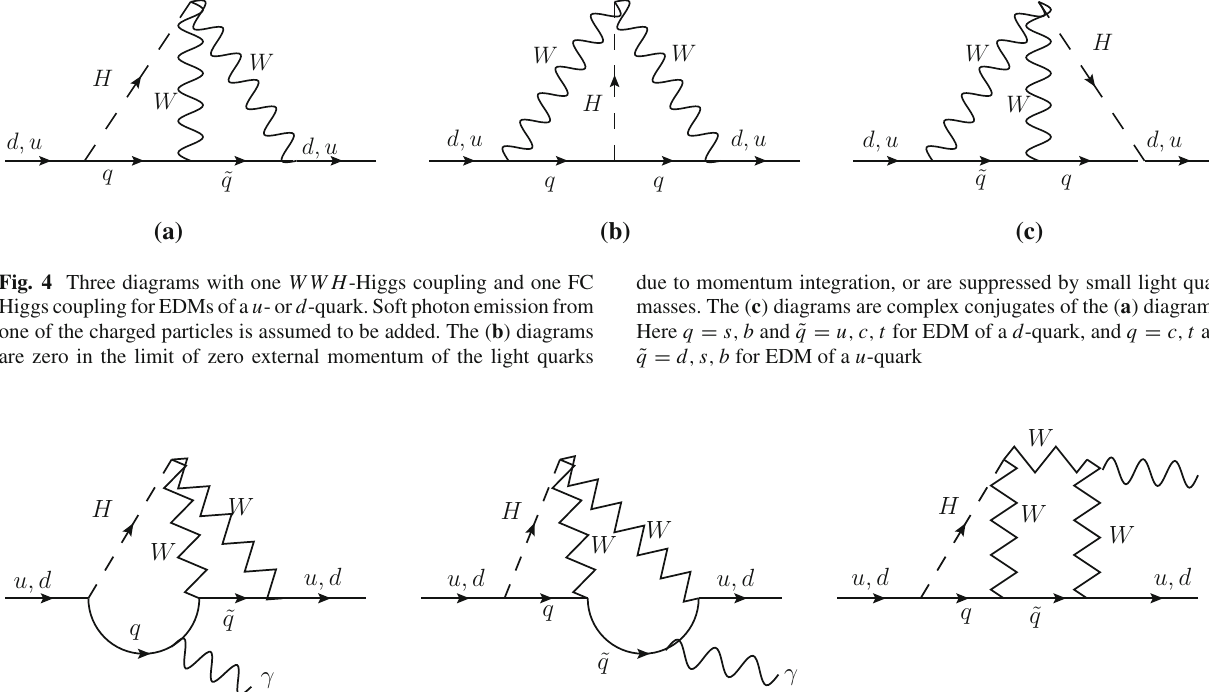
Fig. 5 Emission of a soft photon from (a)-type diagrams of Fig. 4. There is also a diagram with emission from the W in center of the diagram, and in addition graphs with the W replaced by an unphysical Higgs within Feynman